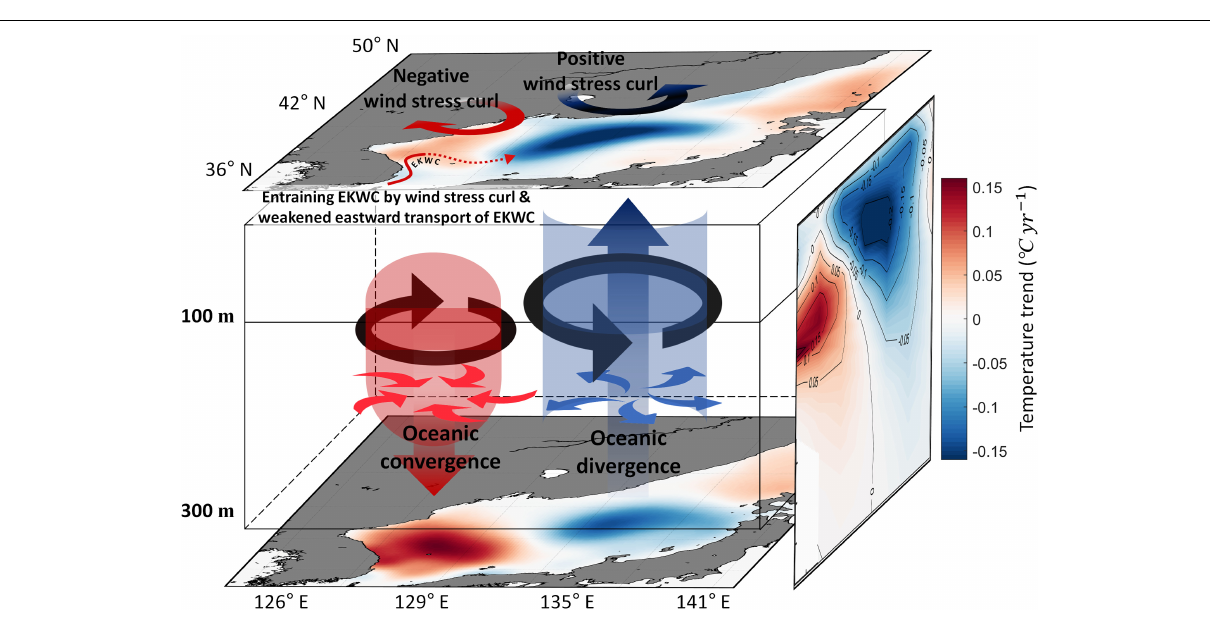
(cid:48) (cid:48) and H (blue vs. black SLA Nonsteric